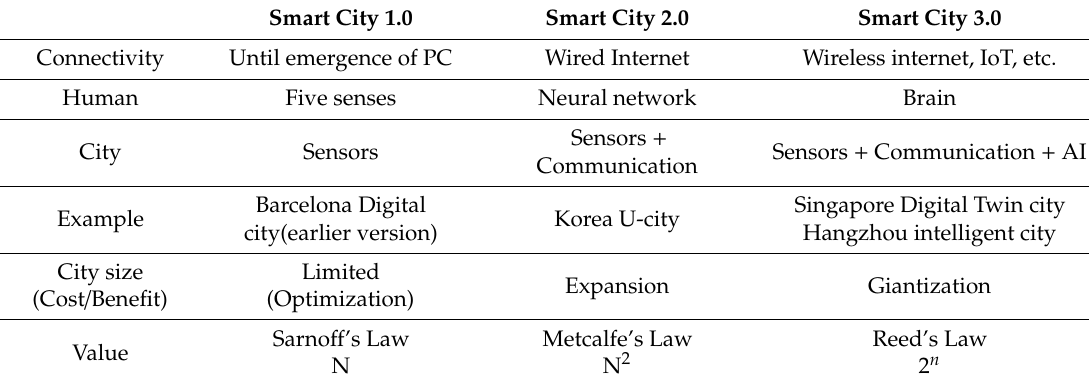
Table 2. Smart City evolution